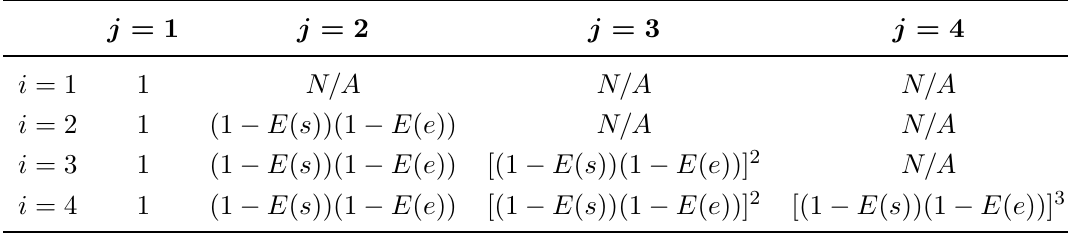
) for different values of i and j . i,j